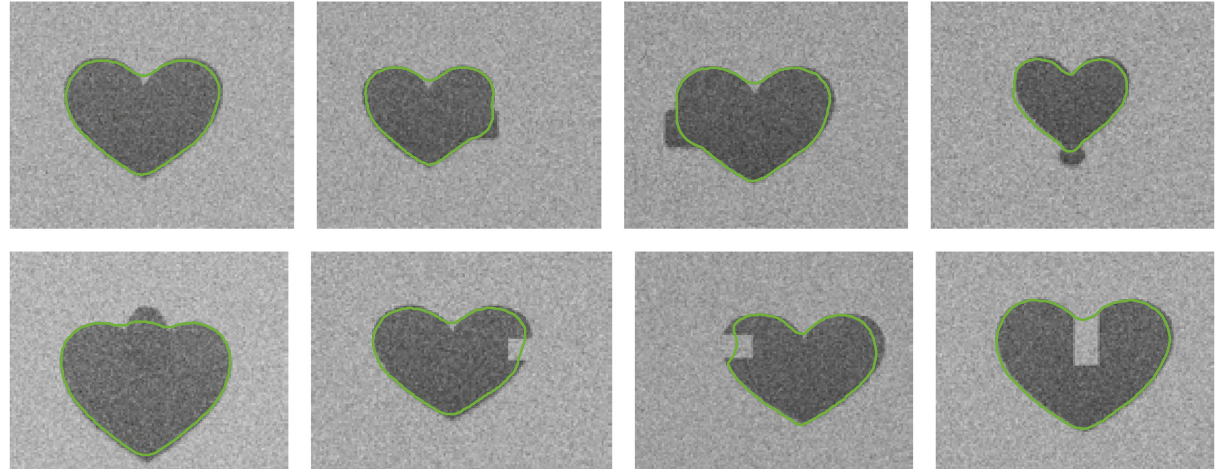
Figure 5: The results with the proposed